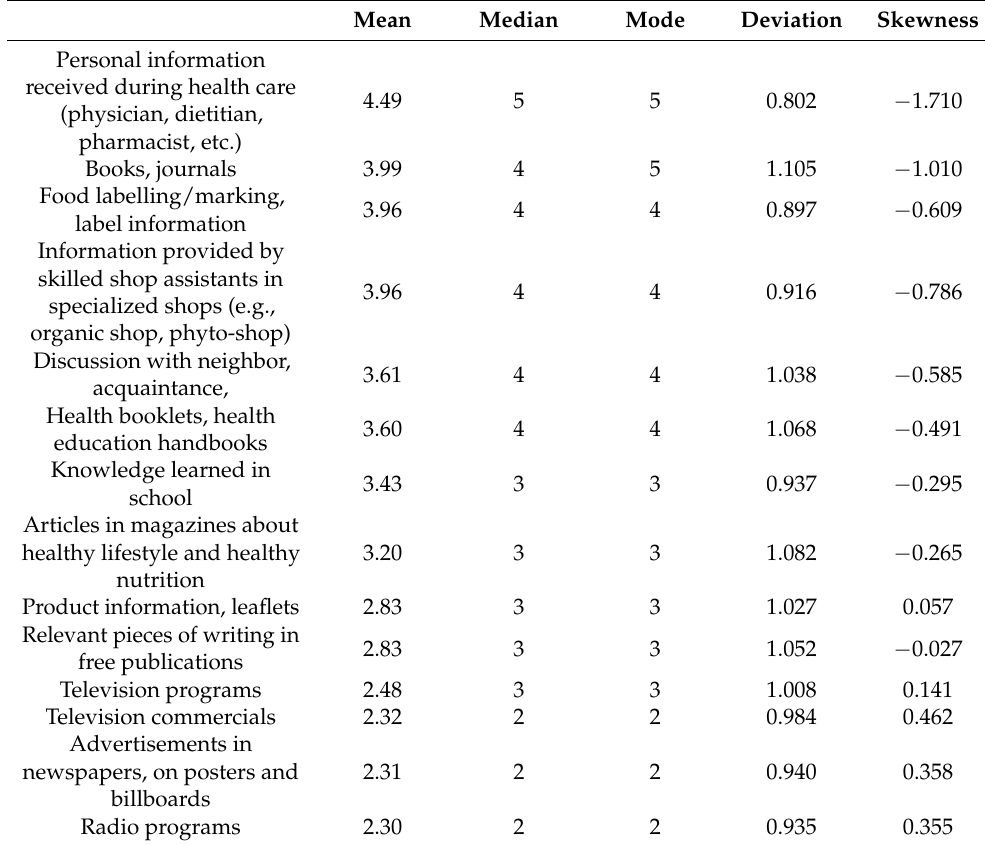
Table 3. Examination of offline sources of information related to healthy nutrition based on their importance ( n =